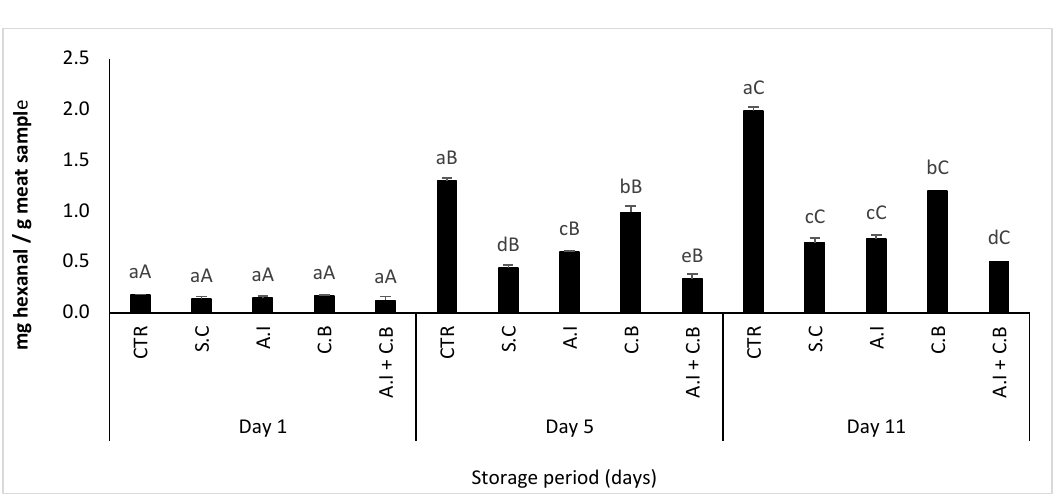
Figure 5. Hexanal content in beef patties during 11 days of refrigerated storage at 4 ± 1 °C. CTR (Control sample without antioxidant), S.C (treatment with 0.7% (w/w) synthetic conservative), A.I (treatment with 0.7% (w/w) powdered A. indica leaves), C.B (treatment with 0.7% (w/w) powdered C. baccatum fruits) and A.I + C.B (treatment with 0.7% (w/w) powdered A. indica leaves and 0.7% (w/w) powdered C. baccatum fruits). Results represent the mean of three replicates ( n = 3) and are expressed as mean value ± SD; different letters in the same day indicate significant difference between samples at p < 0.05, different capital letters indicate significant difference between storage days at p < 0.05 for the same sample.